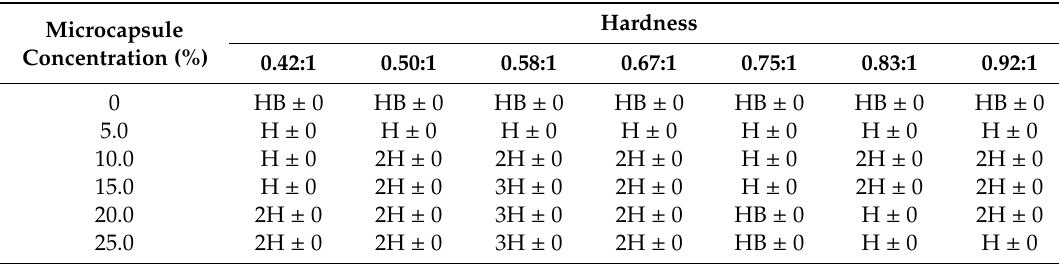
Table 5. E ff ect of the Concentration of Microcapsules with the Di ff erent Core–Wall Ratios on the Hardness of Waterborne Primer